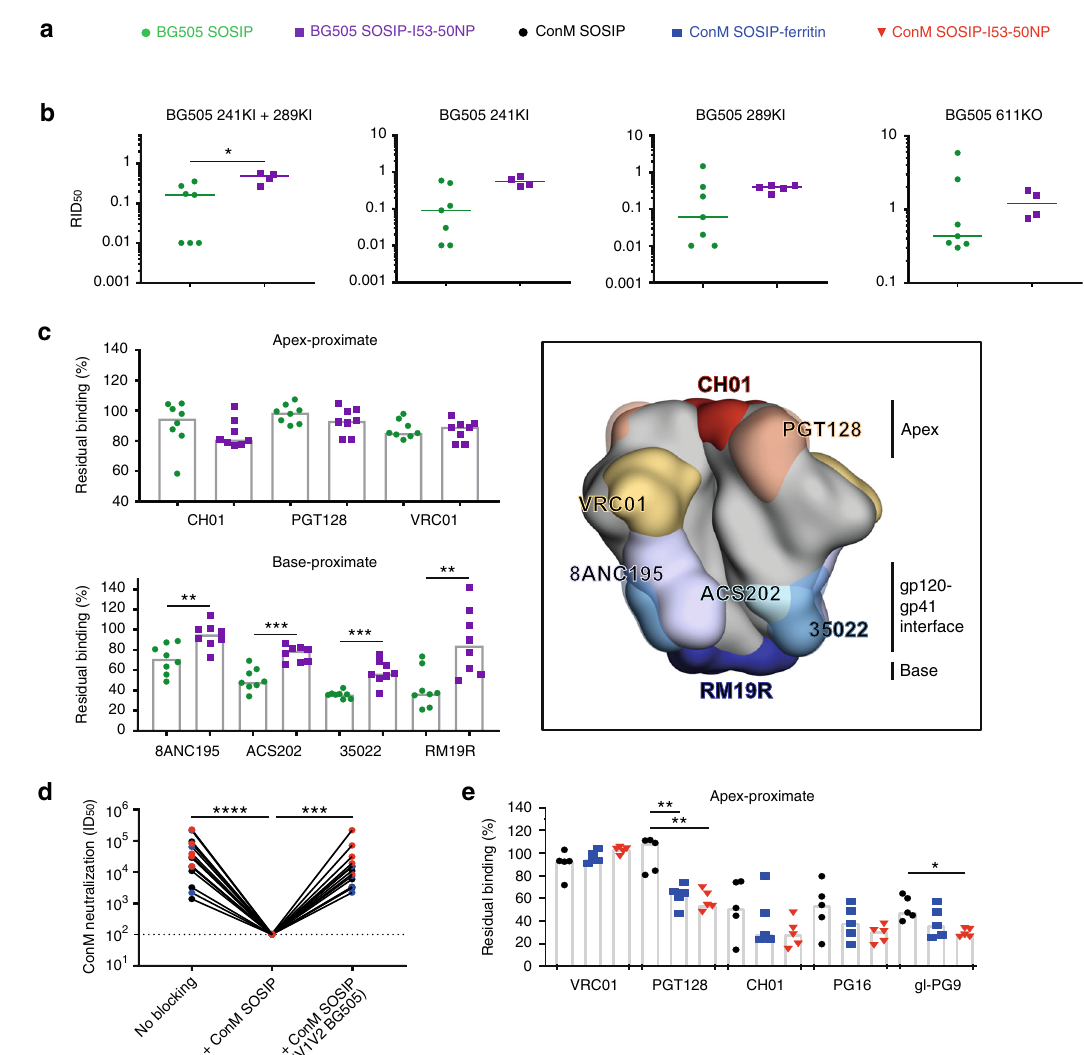
Fig. 6 Epitope mapping of BG505 and ConM SOSIP-I53-50NP-induced (N)Ab responses. a Color coding for b – e . b – e Statistical differences between two groups were determined using unpaired two-tailed Mann – Whitney U -tests (* p < 0.05; ** p < 0.01; *** p < 0.001). b Ratio of midpoint neutralization titers of several BG505 virus mutants relative to the parental BG505 virus is plotted (RID 50 ). Mutants shown are BG505 with glycans knocked in at position 241 and 289 (BG505 241KI + 289KI), position 241 (BG505 241KI), position 289 (BG505 289KI), or a glycan knocked out at position 611 (BG505 611KO). Epitope mapping was only performed for sera from rabbits that had an ID 50 > 100 ( n = 7 individual rabbits, for BG505 SOSIP recipients; n = 4 individual rabbits for BG505 SOSIP-I53-50NP recipients). See also Supplementary Table 3. Horizontal bars indicate the median. c Residual binding of bNAbs CH01, PGT128, VRC01, 8ANC195, ACS202, 35O22, and non-NAb RM19R after incubation of sera ( n = 8 individual rabbits) with immobilized BG505 SOSIP in ELISA (left) and surface model of BG505 SOSIP (gray) with the corresponding Ab footprints highlighted. Bars indicate the median. d Midpoint autologous ConM neutralization in the absence of a blocking agent (no blocking), with ConM SOSIP added ( + ConM SOSIP) or with ConM SOSIP that has the V1V2- loop of BG505 ( + ConM SOSIP (V1V2 BG505)). Statistical differences between the three groups ( n = 5 individual rabbits) was determined using a Friedman test followed by a Dunn ’ s multiple comparisons test (*** p < 0.001; **** p < 0.0001). e Residual binding of bNAbs VRC01, PGT128, CH01, PG16, and gl-PG9 after incubation of sera with immobilized ConM SOSIP in ELISA. Bars indicate the median ( n = 5 individual rabbits). Source data are provided